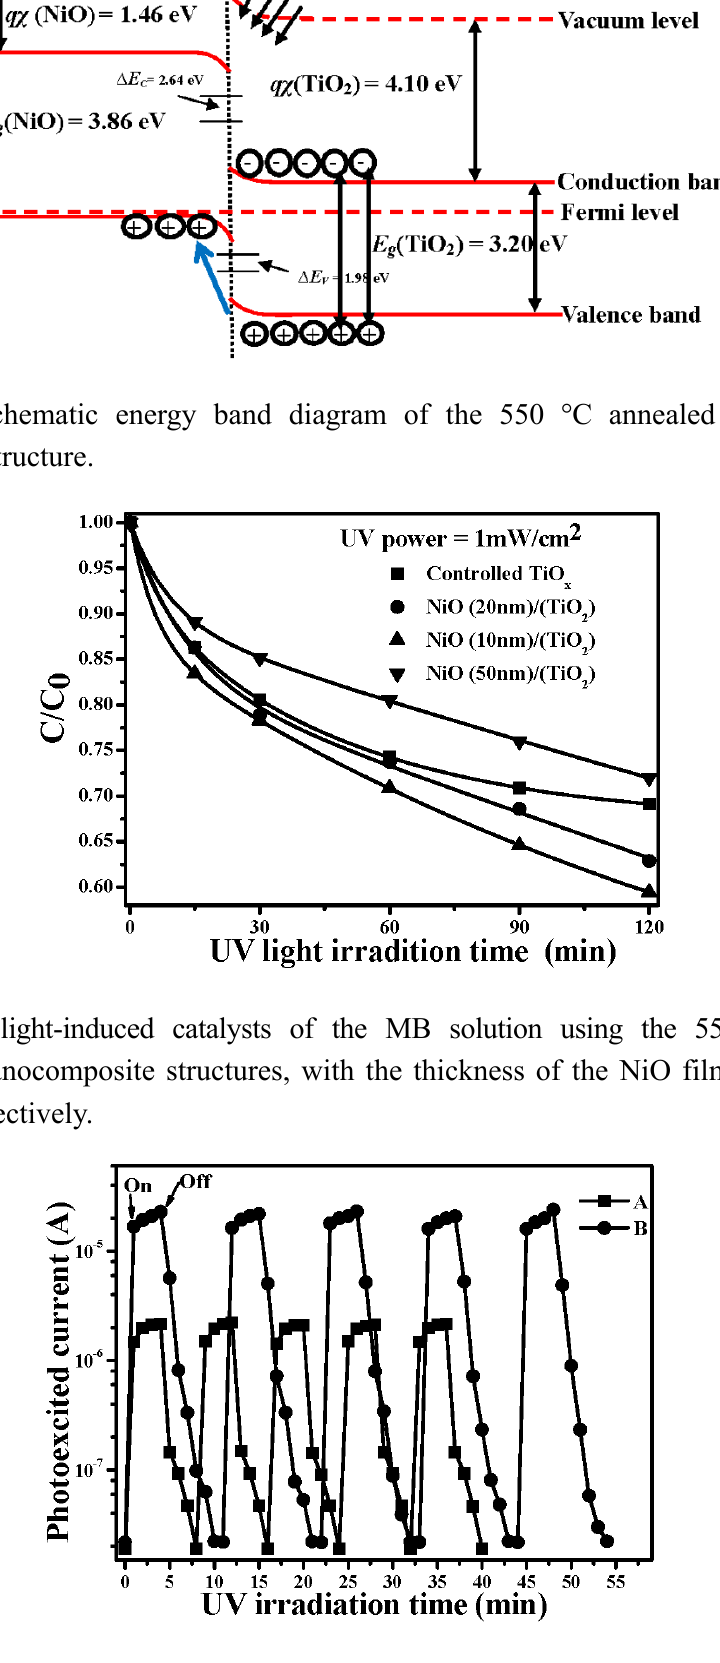
Figure 9. Transient photo-excited current responses of the controlled TiO 2 film (curve A) and the 550 °C-annealed NiO/TiO 2 nanocomposite structure (curve